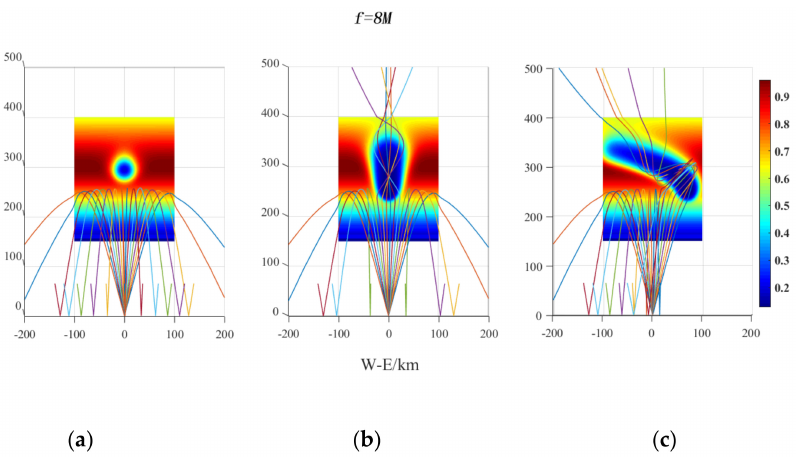
Figure 9. 3D ray-tracing simulation of 8 MHz short wave propagation path after 100 s of H 2 O released by rocket under different flight paths (electron density unit: 10 6 cm − 3 ); ( a ) 300 km fixed − point release, ( b ) 250 − 350 km vertical path, ( c ) 250 − 350 km parabolic